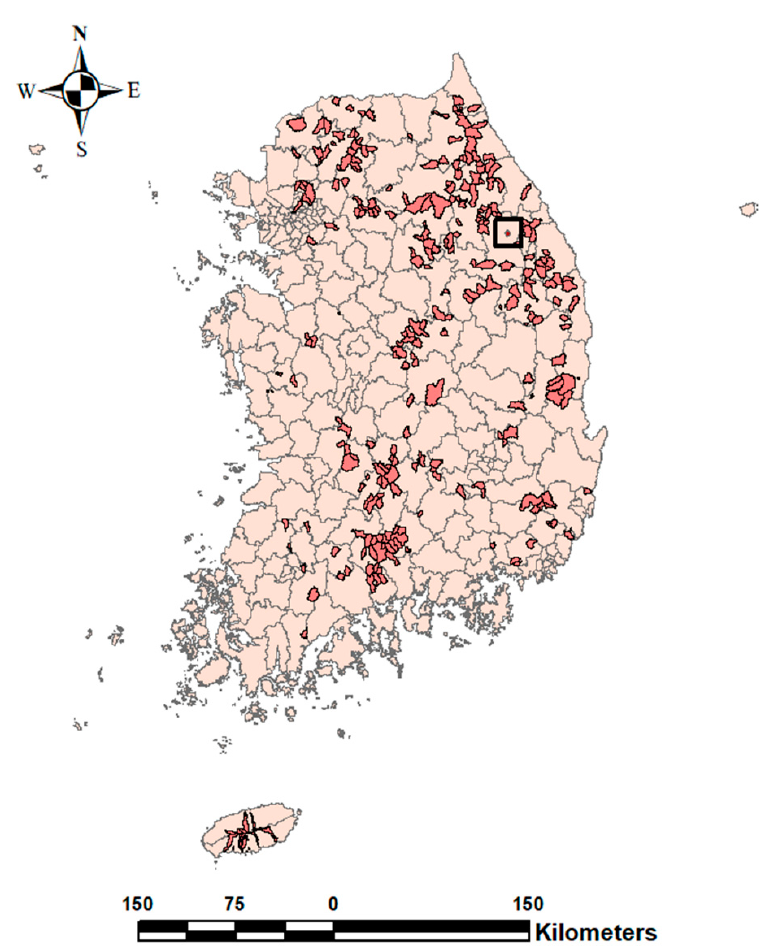
Figure 3. A total of 300 flash flood warning sites over the Korean Peninsula and the location of the Ducsanggi Valley (inside the solid box) considered as an example in this study.